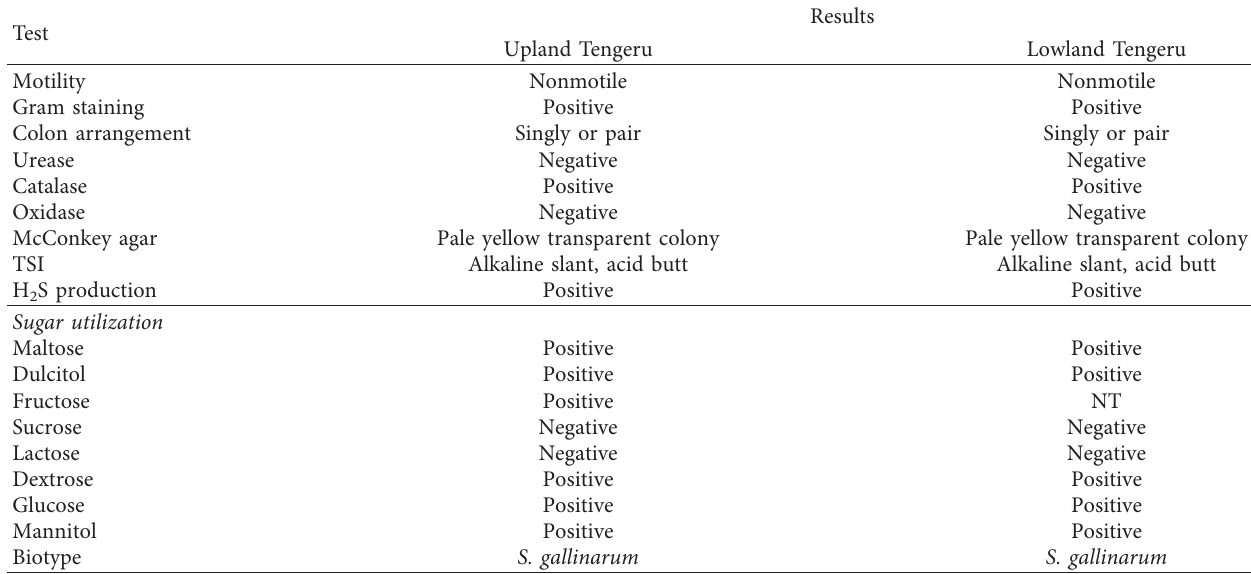
Table 4: Biochemical reactions of Salmonella